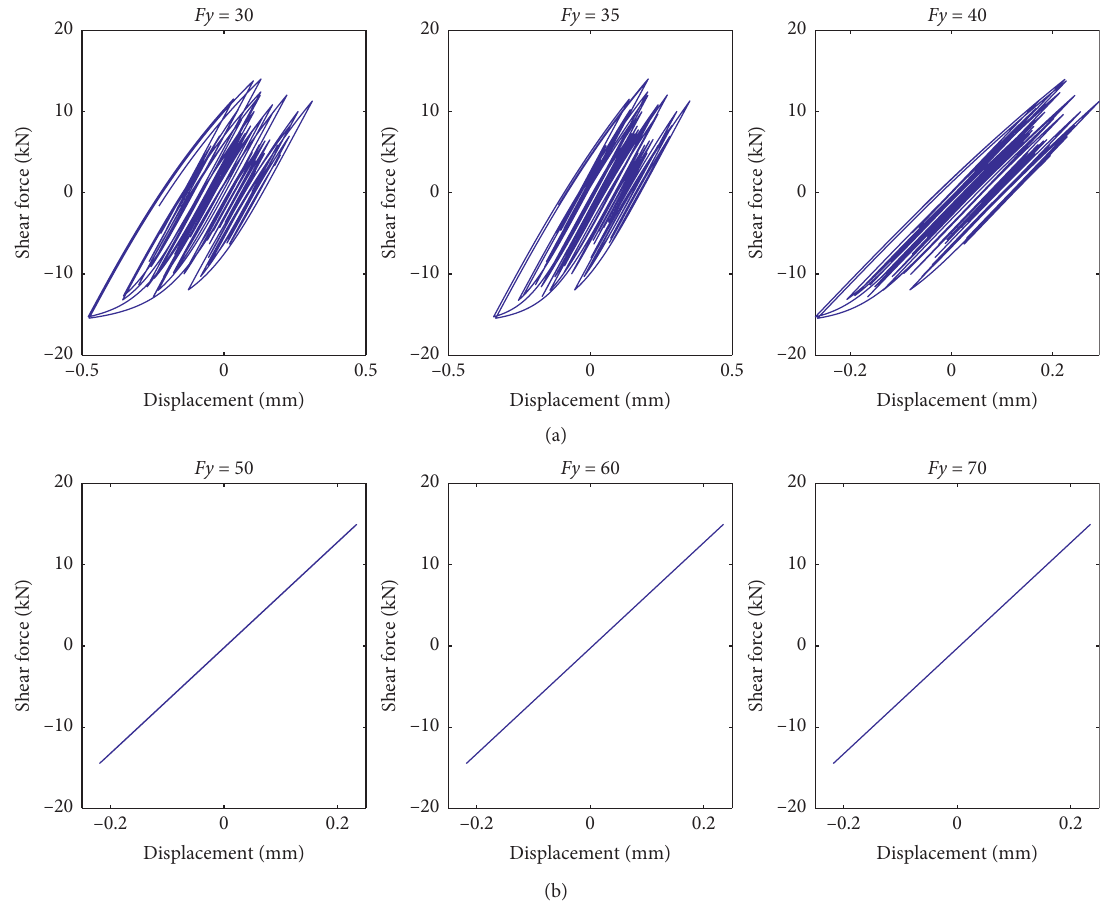
Figure 22: Hysteresis in shear direction ( Kd / Kb � 0.2).